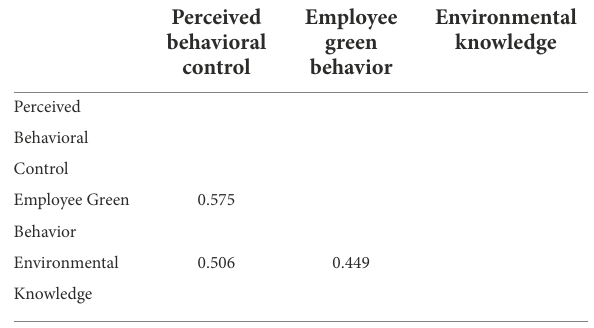
TABLE 6 Evaluation of the structural